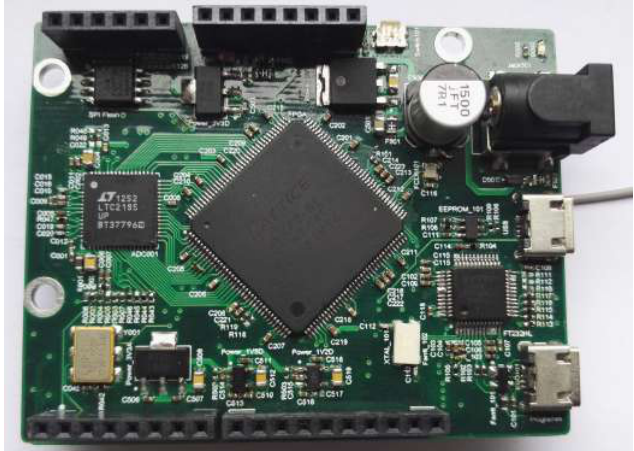
Fig. 1. Hardware design based on a LatticeXP2